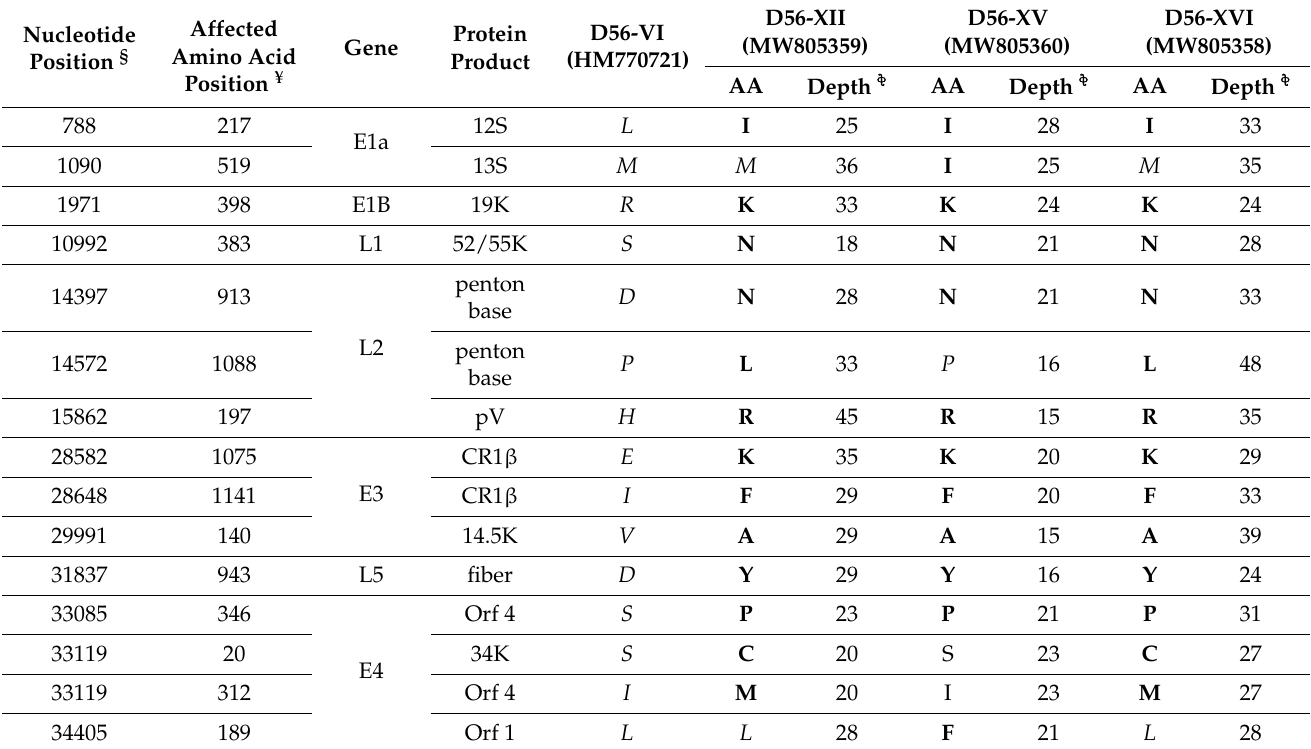
Table 2. Identified non-synonymous point mutations in the genomes of the US strains of HAdV-D56 (D56-XII, -XV, and -XVI) compared to the prototype strain isolated in France in 2008 (D56-VI).